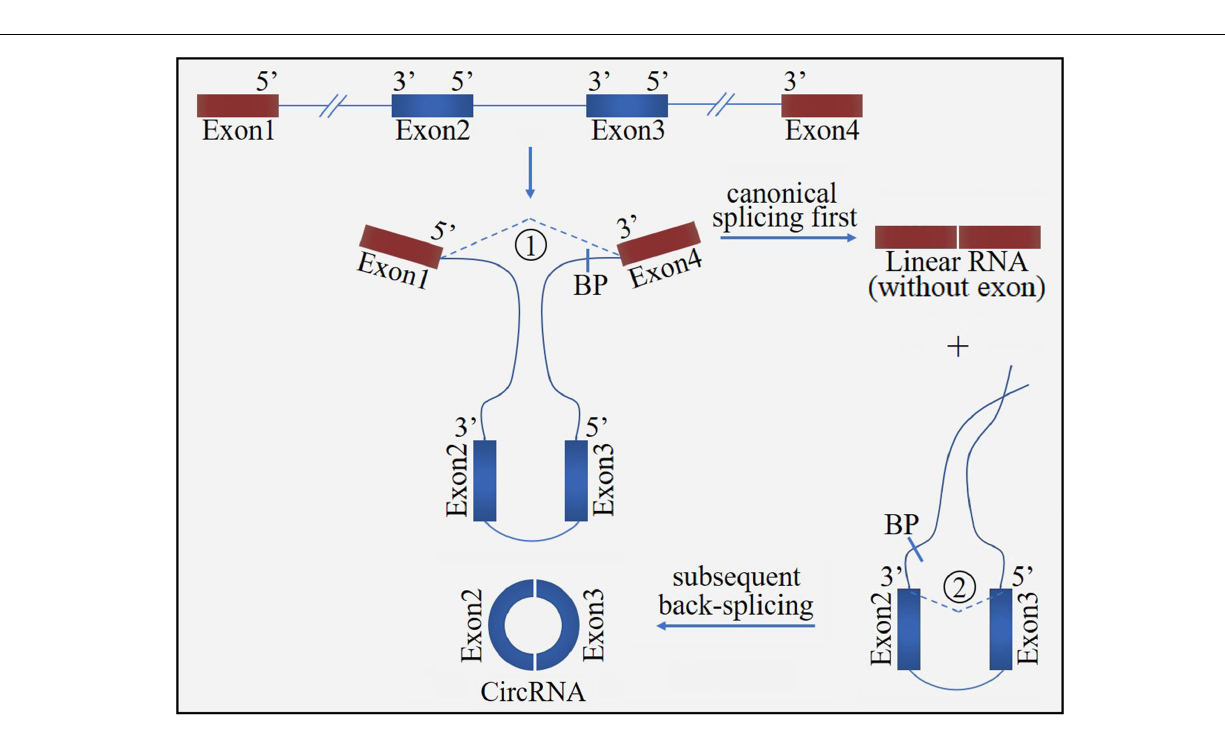
Frontiers in Molecular Neuroscience |